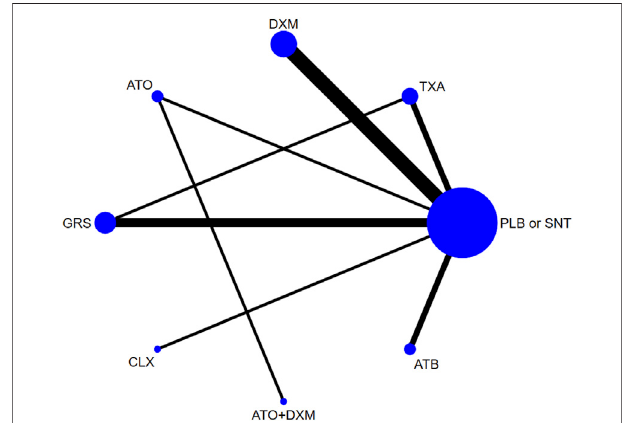
FIGURE 4 | Network plot. Abbreviations: TXA, tranexamic acid; DXM, dexamethasone; ATO, atorvastatin; GRS, goreisan; CLX, celecoxib; ATO+DXM, atorvastatin plus dexamethasone; ATB, antithrombotic; PLB or SNT, placebo or standard neurosurgical treatment.